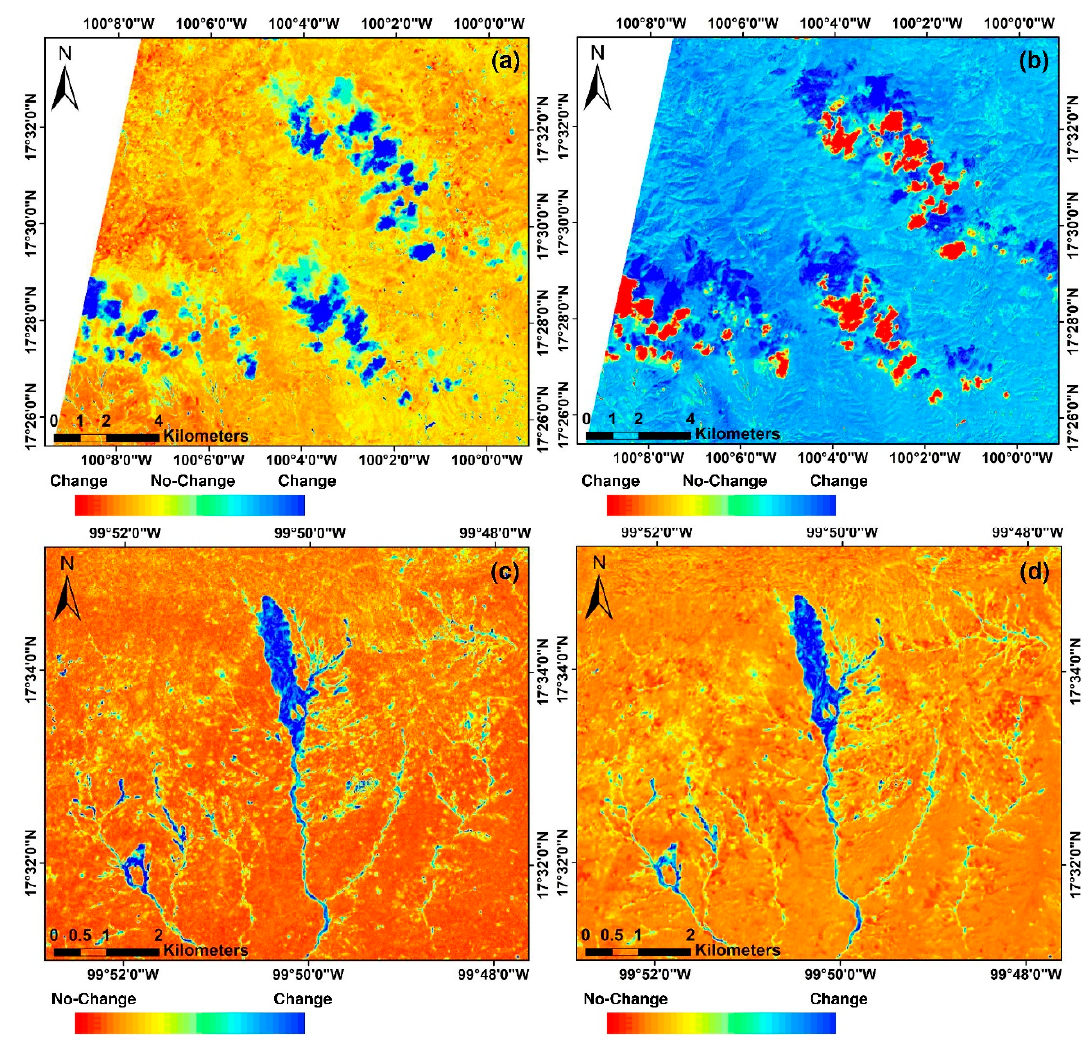
Figure 14. Zoom to change zone caused by clouds in change images ( a ) LR-PC1 and ( b ) LR-NDVI; and caused by landslides in ( c ) CST-PC and ( d ) CVA-PC images.